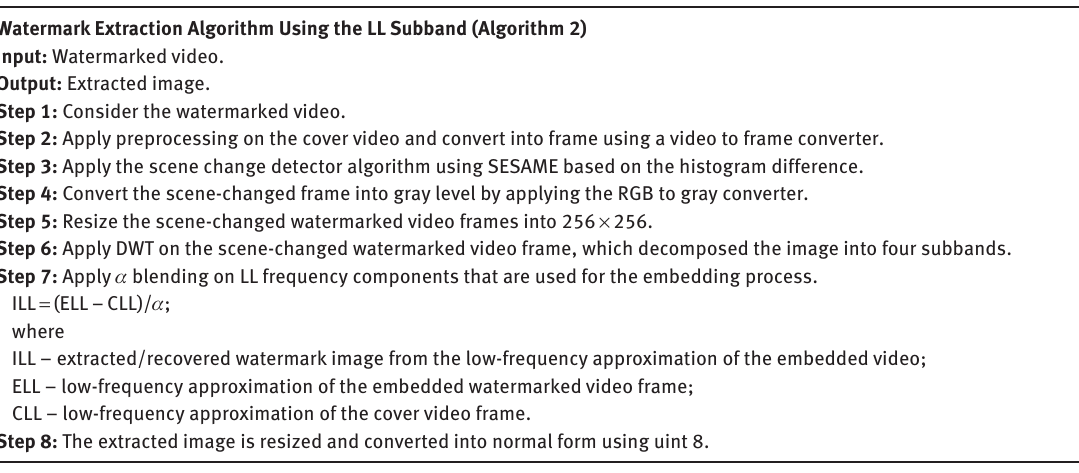
Watermark Extraction Algorithm Using the LL Subband (Algorithm